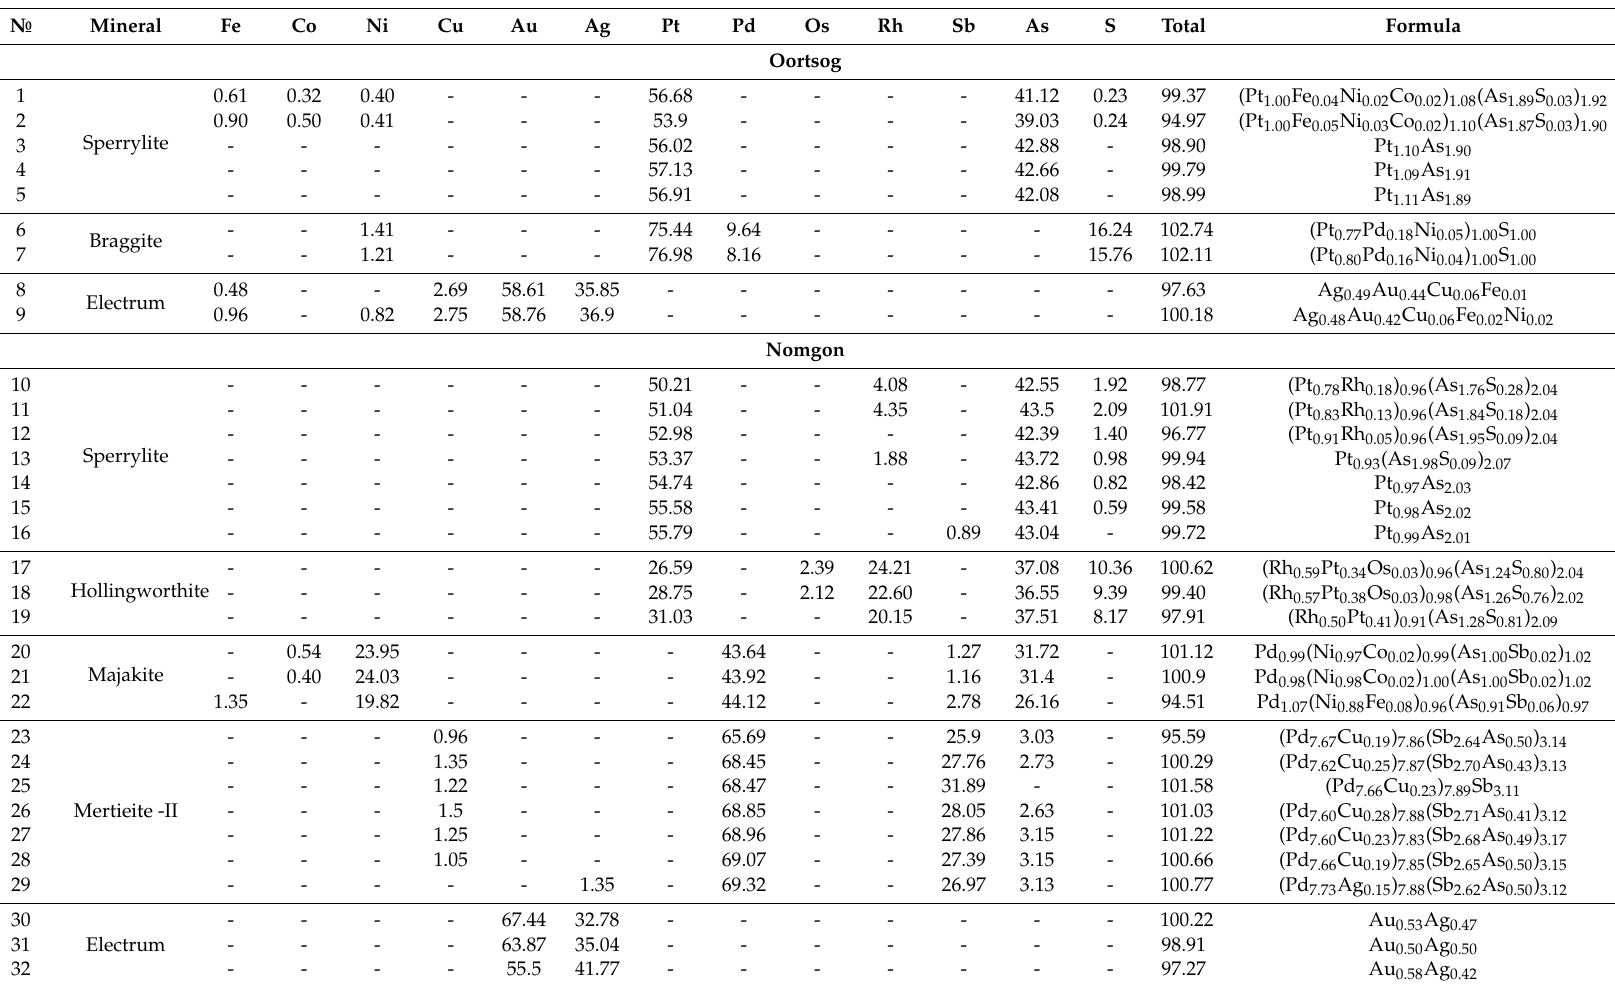
Table 3. Composition of PGE minerals and Au-Ag alloys (wt%) in mafic-ultramafic massifs of the Khangai